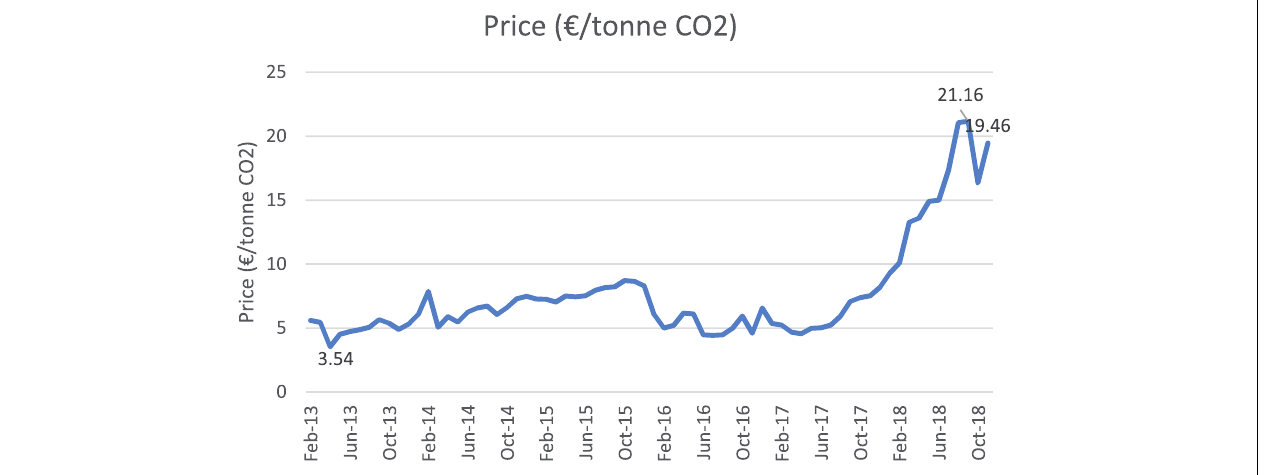
Frontiers in Marine Science |